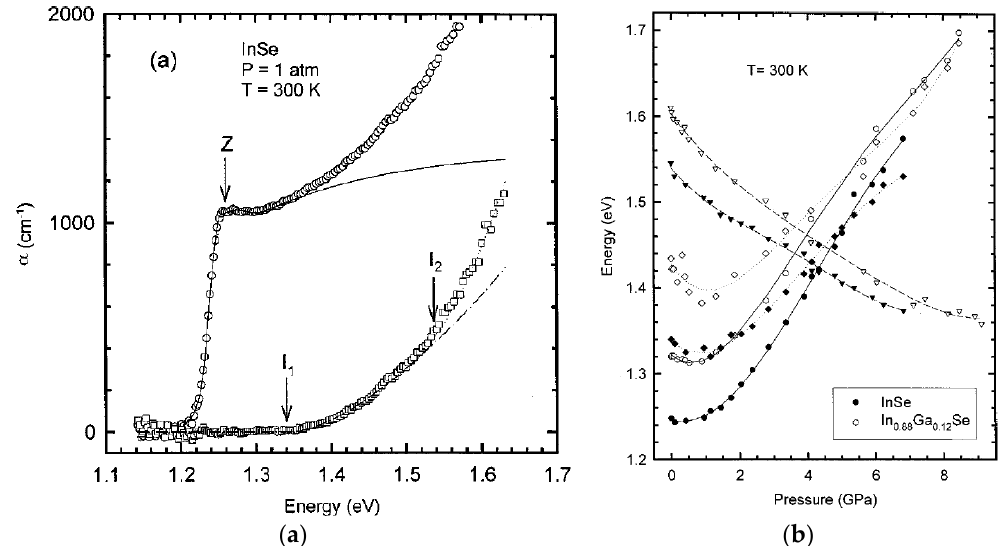
Figure 11. InSe absorption edge under pressure. ( a ) Decomposition of the absorption spectrum in direct and two indirect absorption contributions. ( b ) Pressure dependence of the direct and indirect transitions in InSe and In 0.86 Ga 0.12 Se [64].